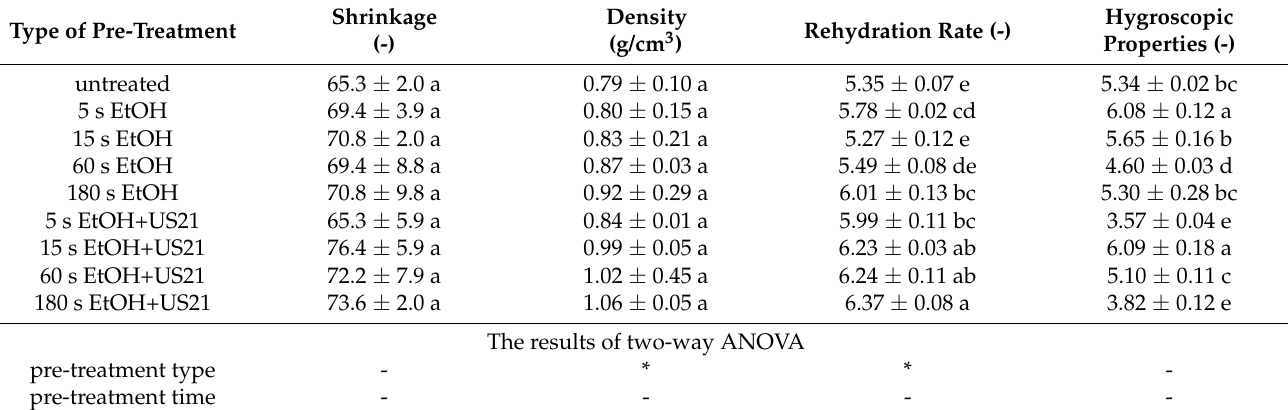
Table 4. Shrinkage, density, rehydration rate (after 3 h of rehydration), hygroscopic properties (after 72 h above NaCl solution) of dried carrot tissue pre-treated without and with ultrasound; error bars indicate ± SD (standard deviation calculated from three